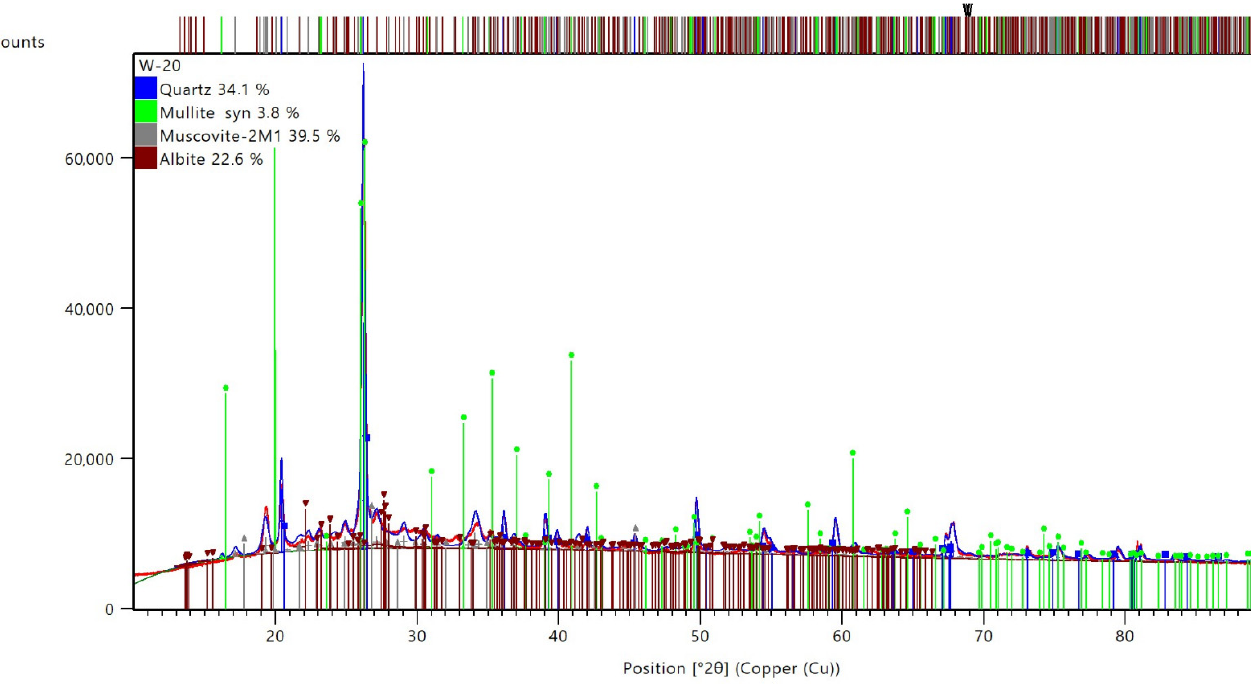
Figure 11. XRD of unheated coal gangue geopolymer foam A1-1 (20 °C).